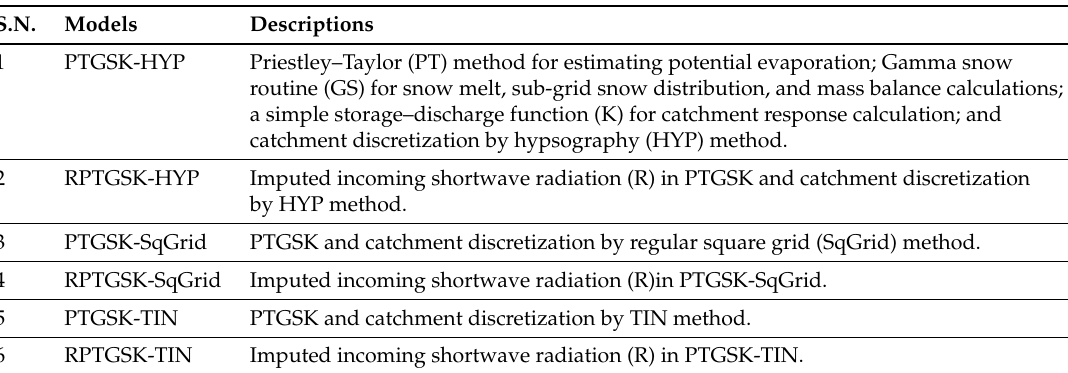
Table 3. Different models with descriptions.